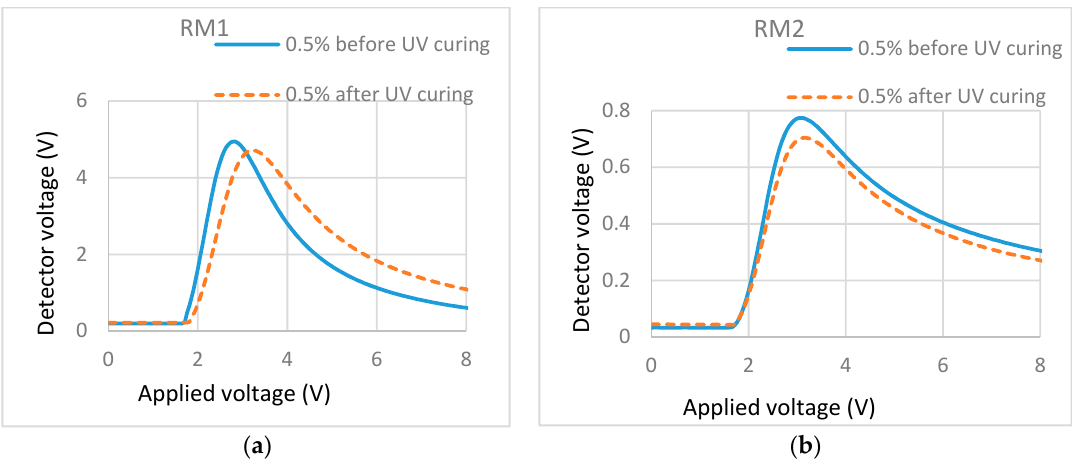
Figure 6. T/V curves of cells containing different monomers in the same LC. ( a ) 0.5% RM257 in ZLI-4792; ( b ) 0.5% Bis-MA in ZLI-4792.